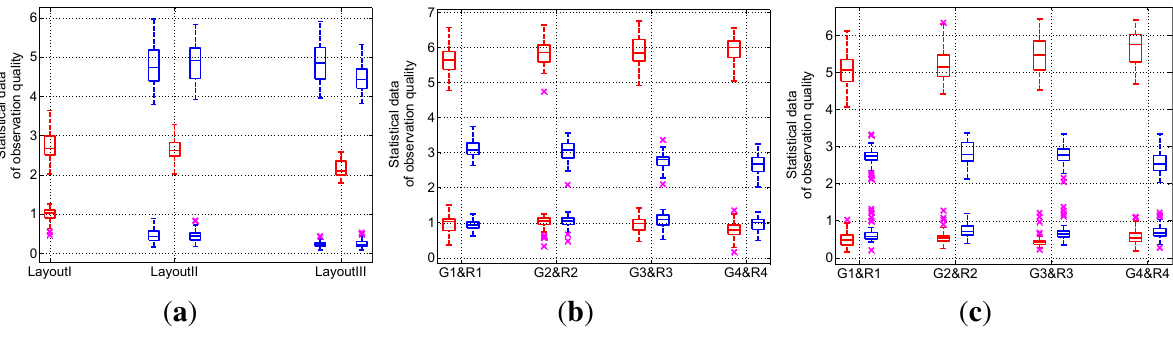
Figure 6. Statistical data of the observation quality distribution of five layout experiments. Blue boxes are the statistical data of critical regions. Red boxes reflect the statistical data of common regions. An upper box and lower box with the same abscissa denote the expectation and variance of the observation quality, respectively. (a) Layout I –Layout III . (b) Layout IV . (c) Layout V . In the figures, G stands for gangway and R for room.